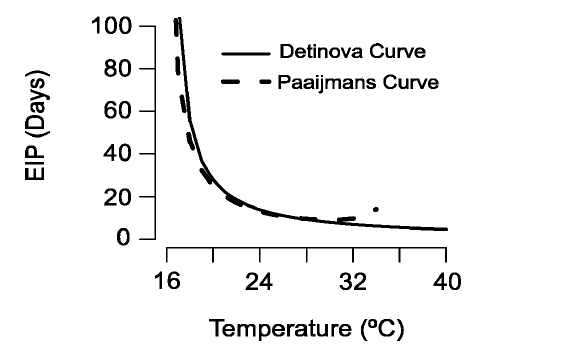
Figure 4. Extrinsic incubation period curves. Temperature- dependent extrinsic incubation period in days; the solid line is the Detinova prediction curve and the dashed line is the Paaijmans curve.